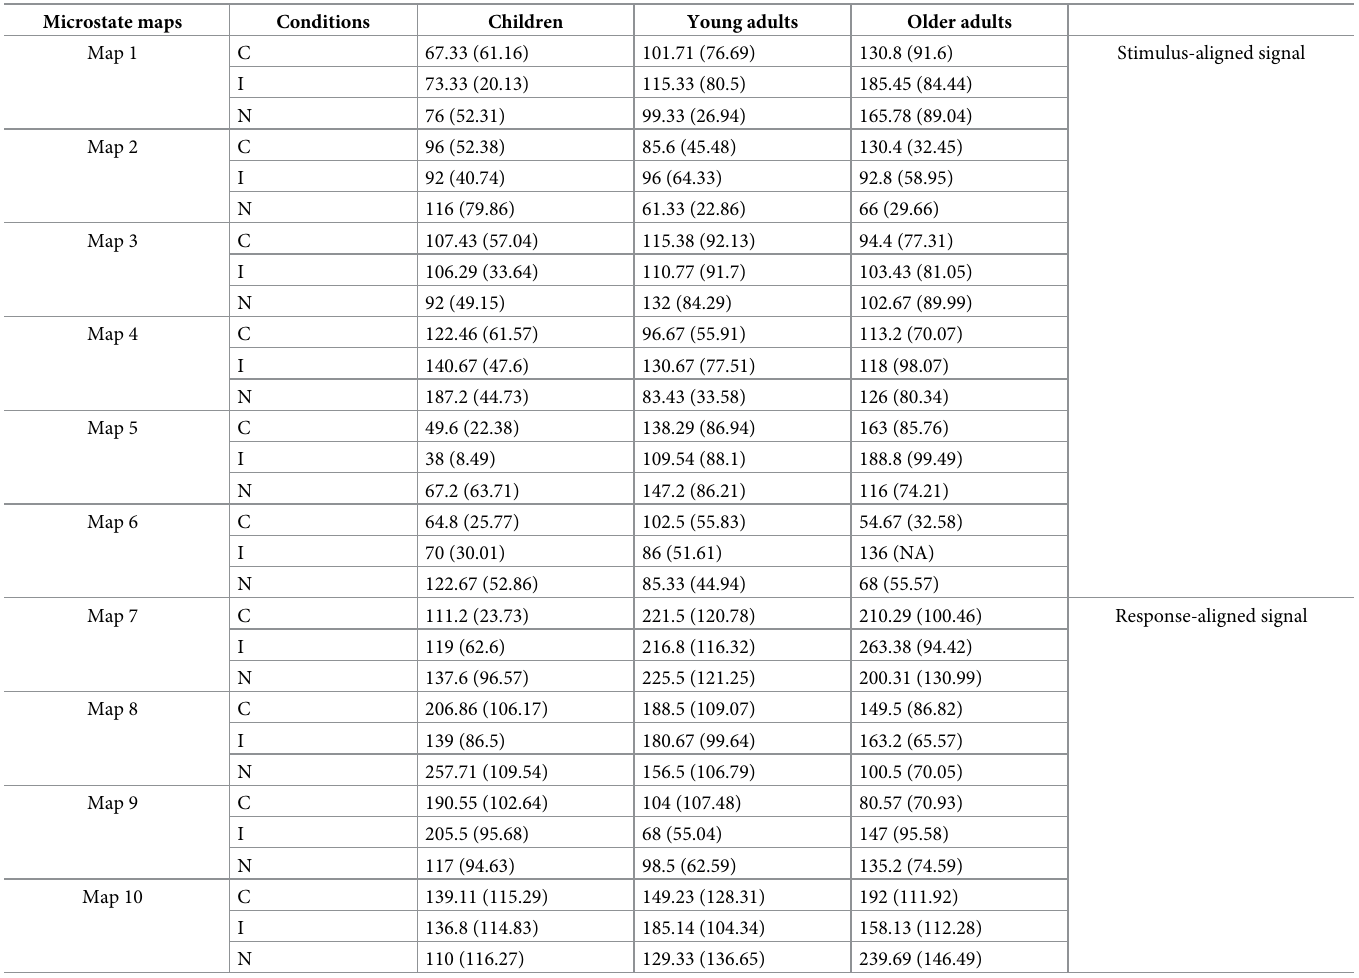
Table 2. Mean and standard deviation of the duration of each map across conditions and age groups. See S3 Fig for graphical representation. Microstate